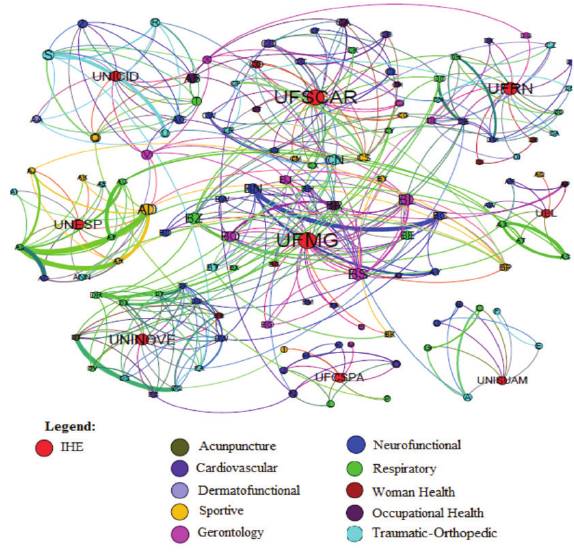
Figure 1 - Collaboration network among physiotherapists teachers of stricto sensu postgraduation programs in physiotherapy in Brazil between the years of 2012 and